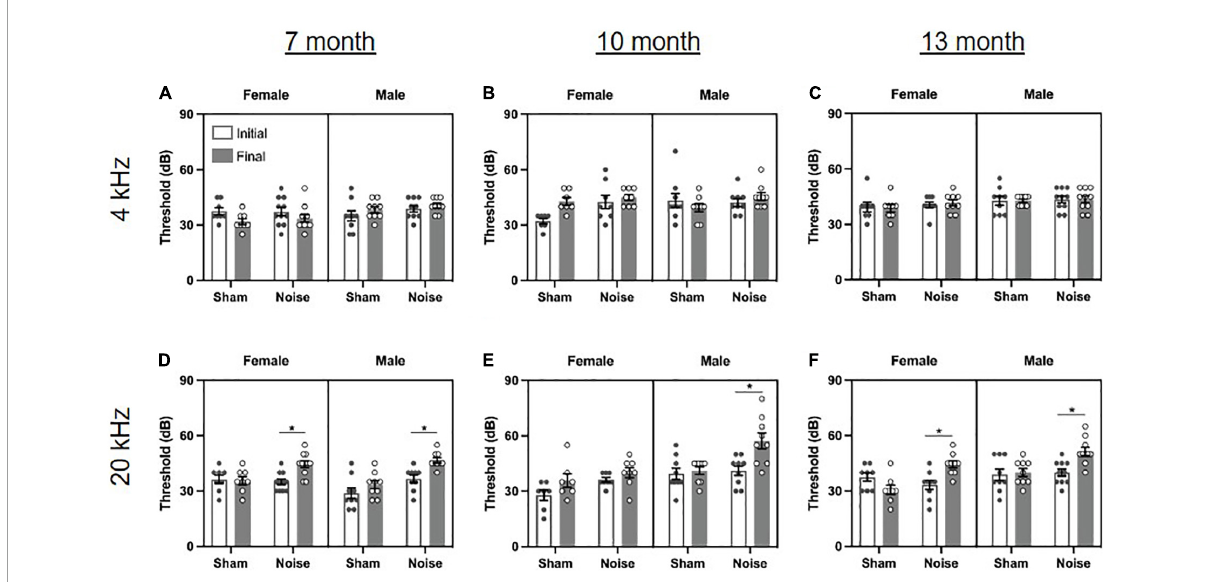
FIGURE2 Noise exposure caused an age- and sex-dependent mild, high-frequency hearing loss. (A–C) The auditory brainstem response (ABR) revealed no changes in hearing sensitivity at the 4 kHz stimulus following noise or sham exposure at 7, 10, or 13 months of age. (D,F) Noise-exposed rats had significantly increased hearing thresholds compared to baseline at the 20 kHz stimulus at 7 and 13 months of age, regardless of sex (* p bonf < 0.05). (E) At 10 months of age, noise-exposed male rats, but not female rats, had significantly increased hearing thresholds at